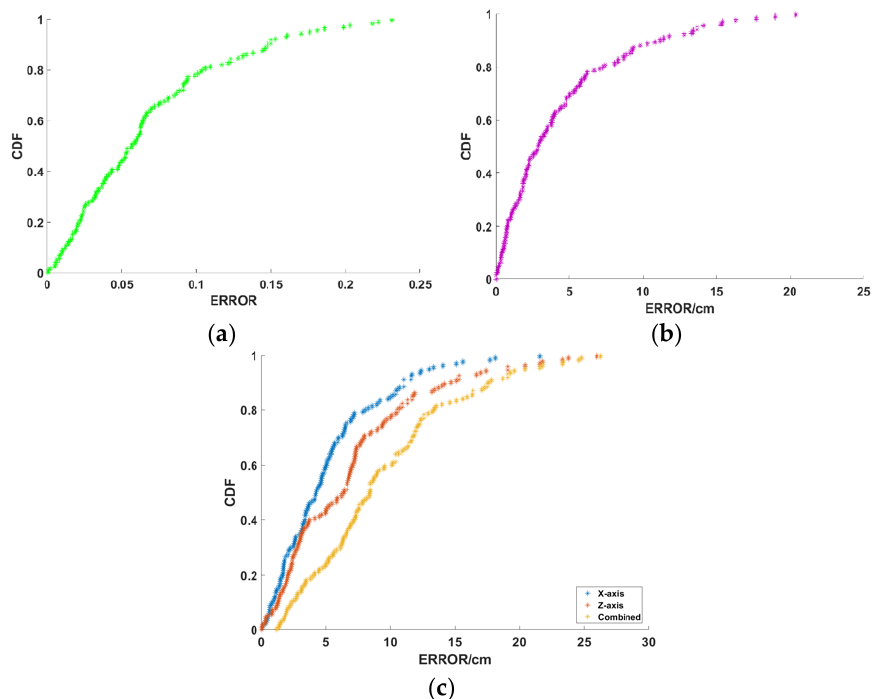
Figure 16. Localization error in 2D. ( a ) Relative incident angle error in 2D; ( b ) Distance calculation error in 2D; and, ( c ) Localization error in 2D.